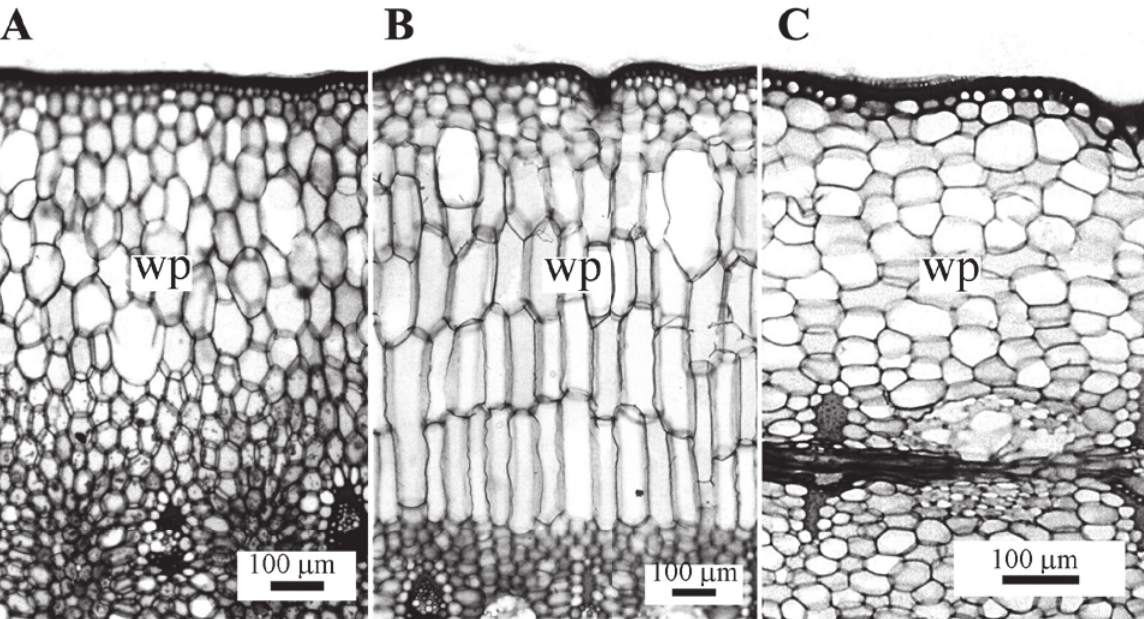
Figure 5 - Transversal sections of Neoregelia cruenta leaves showing water storage parenchyma (wp) in base (A) middle (B) and apex (C) .